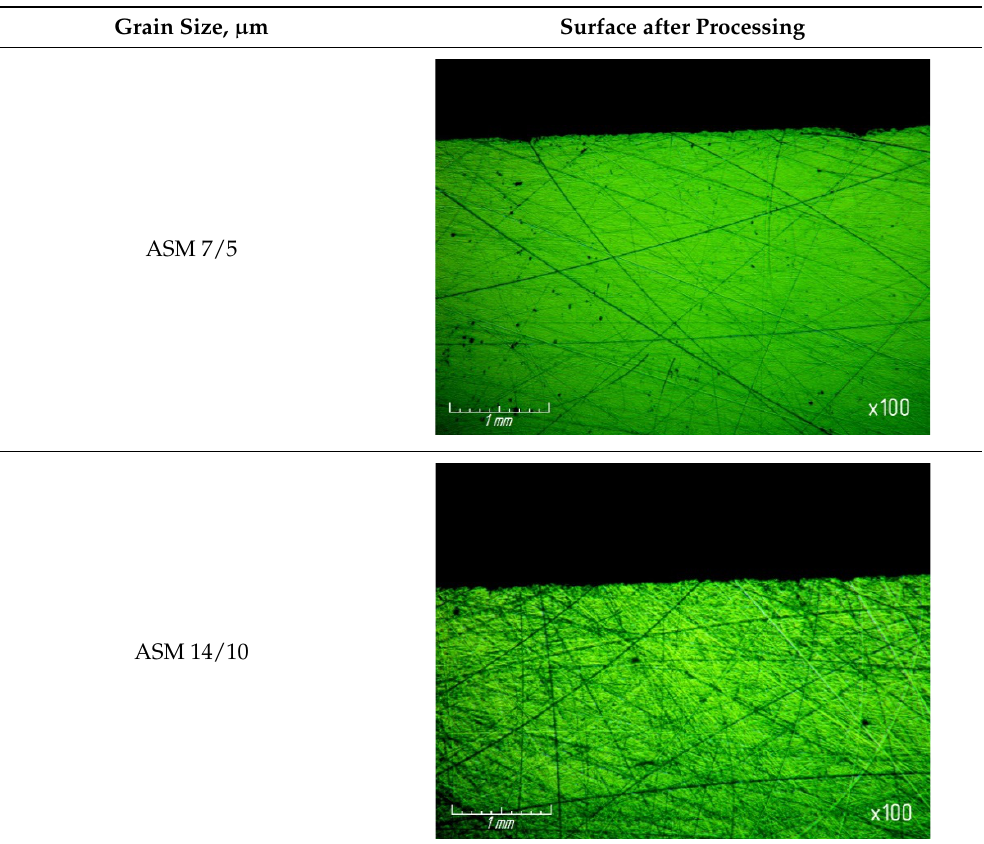
Figure 8. The effect of grain size on the processing performance of ZrO 2 ceramics. Table 3. Photos of the surface finished with diamond paste of different grain size (magnification ×100).